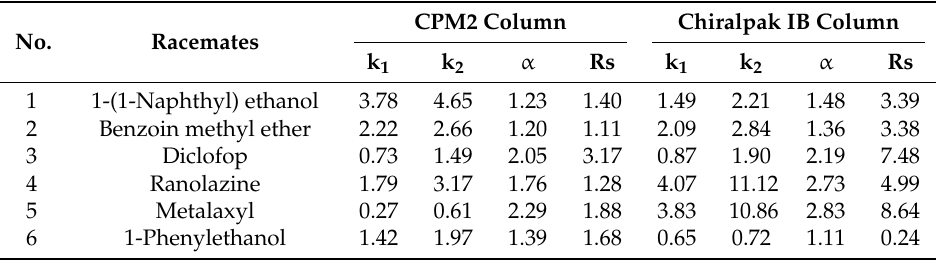
Table 2. Separation of racemates under normal phase mode.